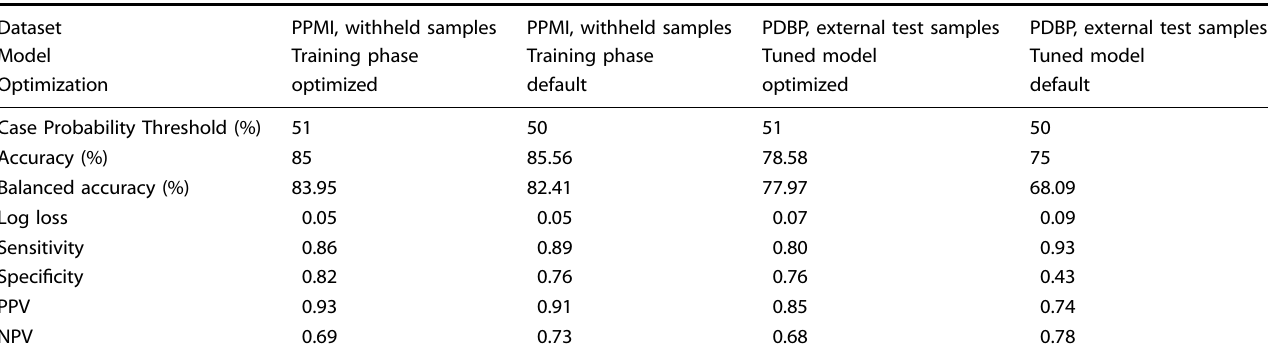
Table 5. Optimizing the AUC threshold in withheld training samples and in the validation data. Dataset PPMI, withheld